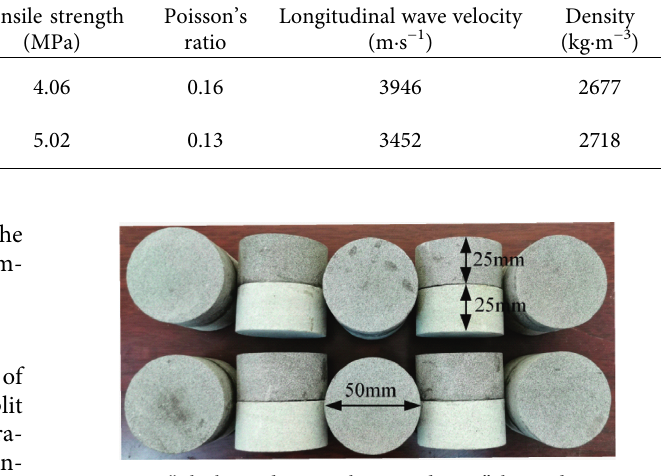
Figure 1: “Black sandstone-white sandstone” layered composite rock